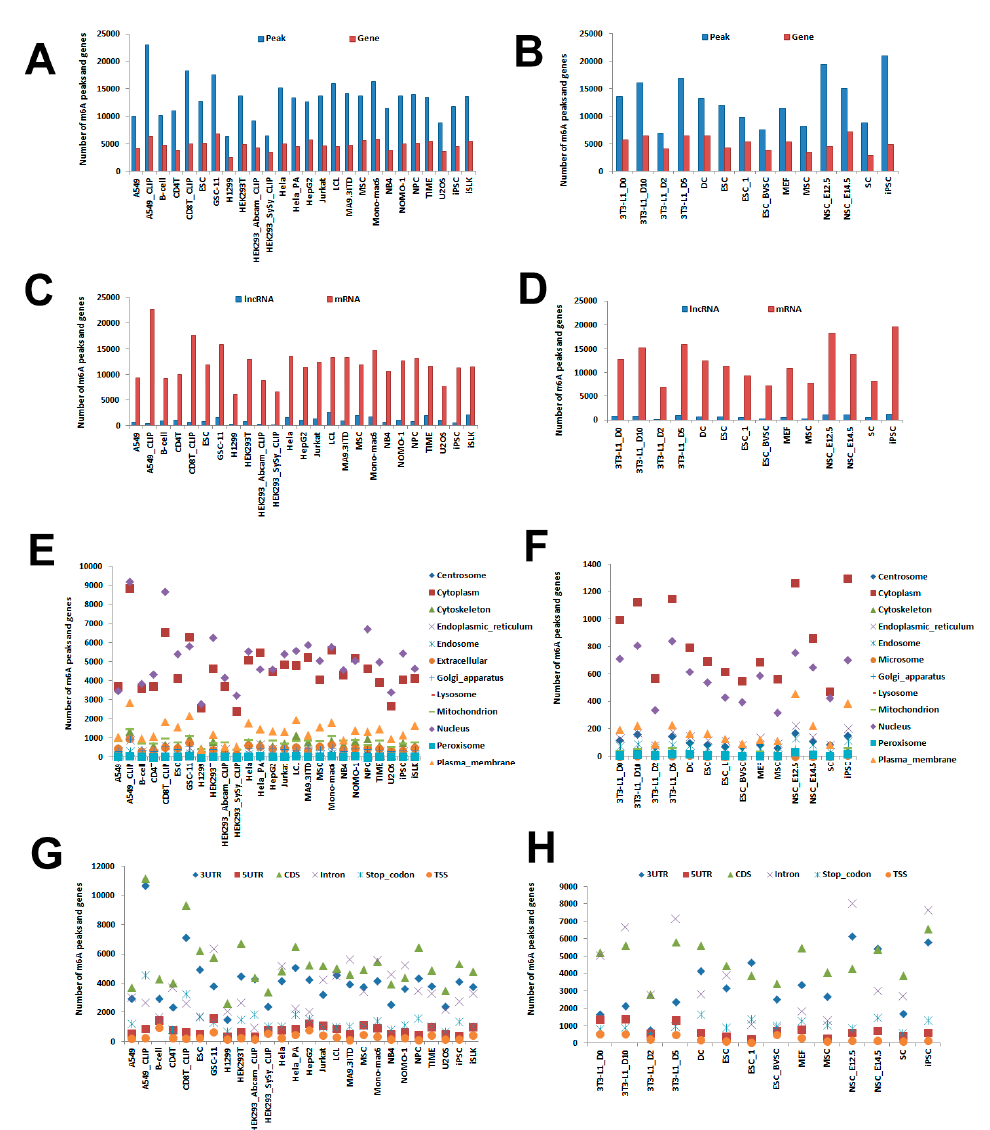
Figure 1. Statistics of m 6 A patterns in CVm6A. ( A ) Number of m 6 A peaks and genes in human cell lines. ( B ) Number of m 6 A peaks and genes in mouse cell lines. ( C ) Number of m 6 A peaks distributed in lncRNA or mRNA in human cell lines. ( D ) Number of m 6 A peaks distributed in lncRNA or mRNA in mouse cell lines. ( E ) Number of m 6 A peaks distributed in 12 subcellular components in human cell lines. ( F ) Number of m 6 A peaks distributed in 12 subcellular components in mouse cell lines. ( G ) Number of m 6 A peaks distributed in 6 gene regions: TSS (Transcription start site), 5’UTR, CDS, Stop codon, 3’UTR and intron in human cell lines. ( H ) Number of m 6 A peaks distributed in 6 gene regions: TSS, 5’UTR, CDS, Stop codon, 3’UTR and intron in mouse cell lines.